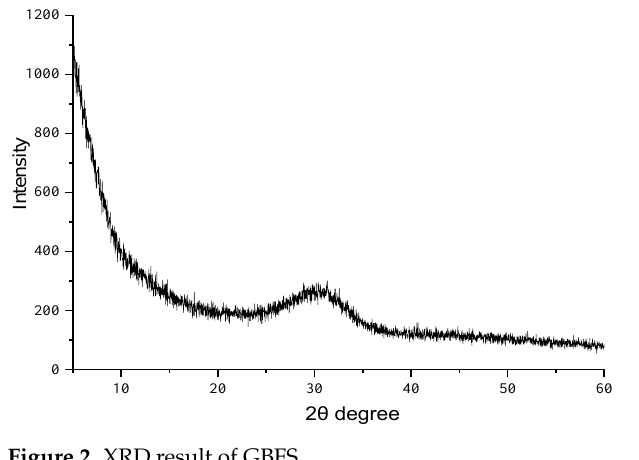
Figure 2. XRD result of GBFS.